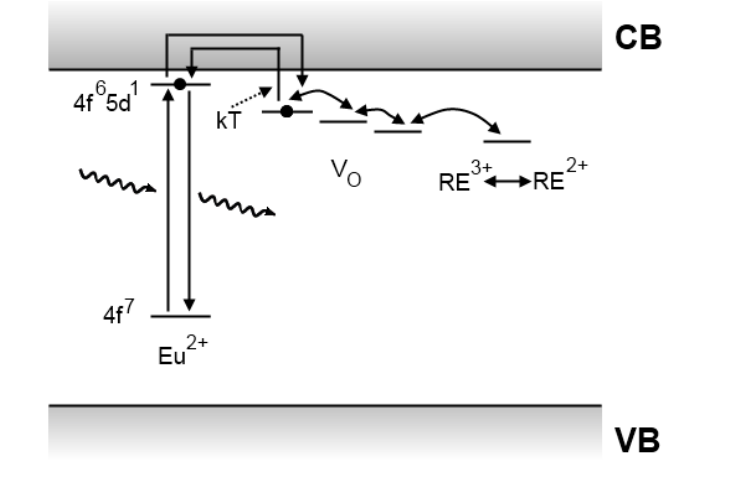
Figure 11. Persistent luminescence mechanism proposed in 2006 by Aitasalo et al . for CaAl O :Eu 2+ ,Dy 3+ 2 4